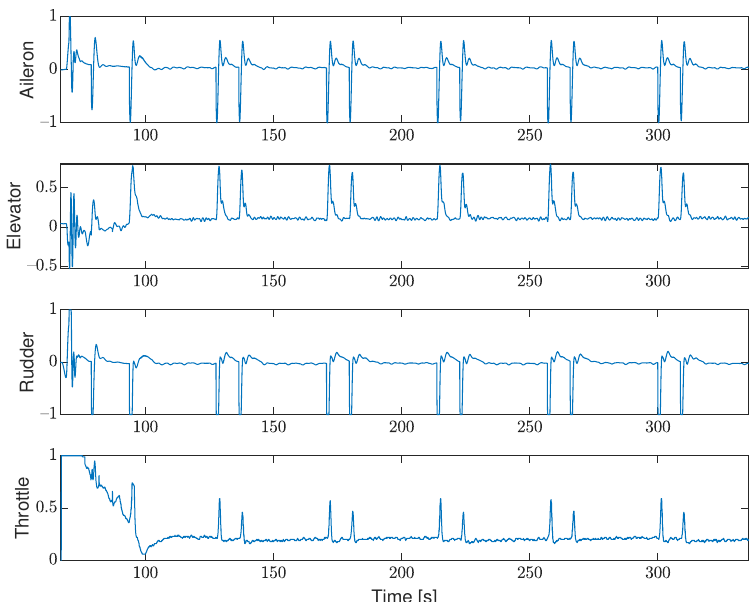
Figure 14. SITL: Control input. Control surface deflections are normalized to [ − 1,1 ] and the throttle to [ 0,1 ]